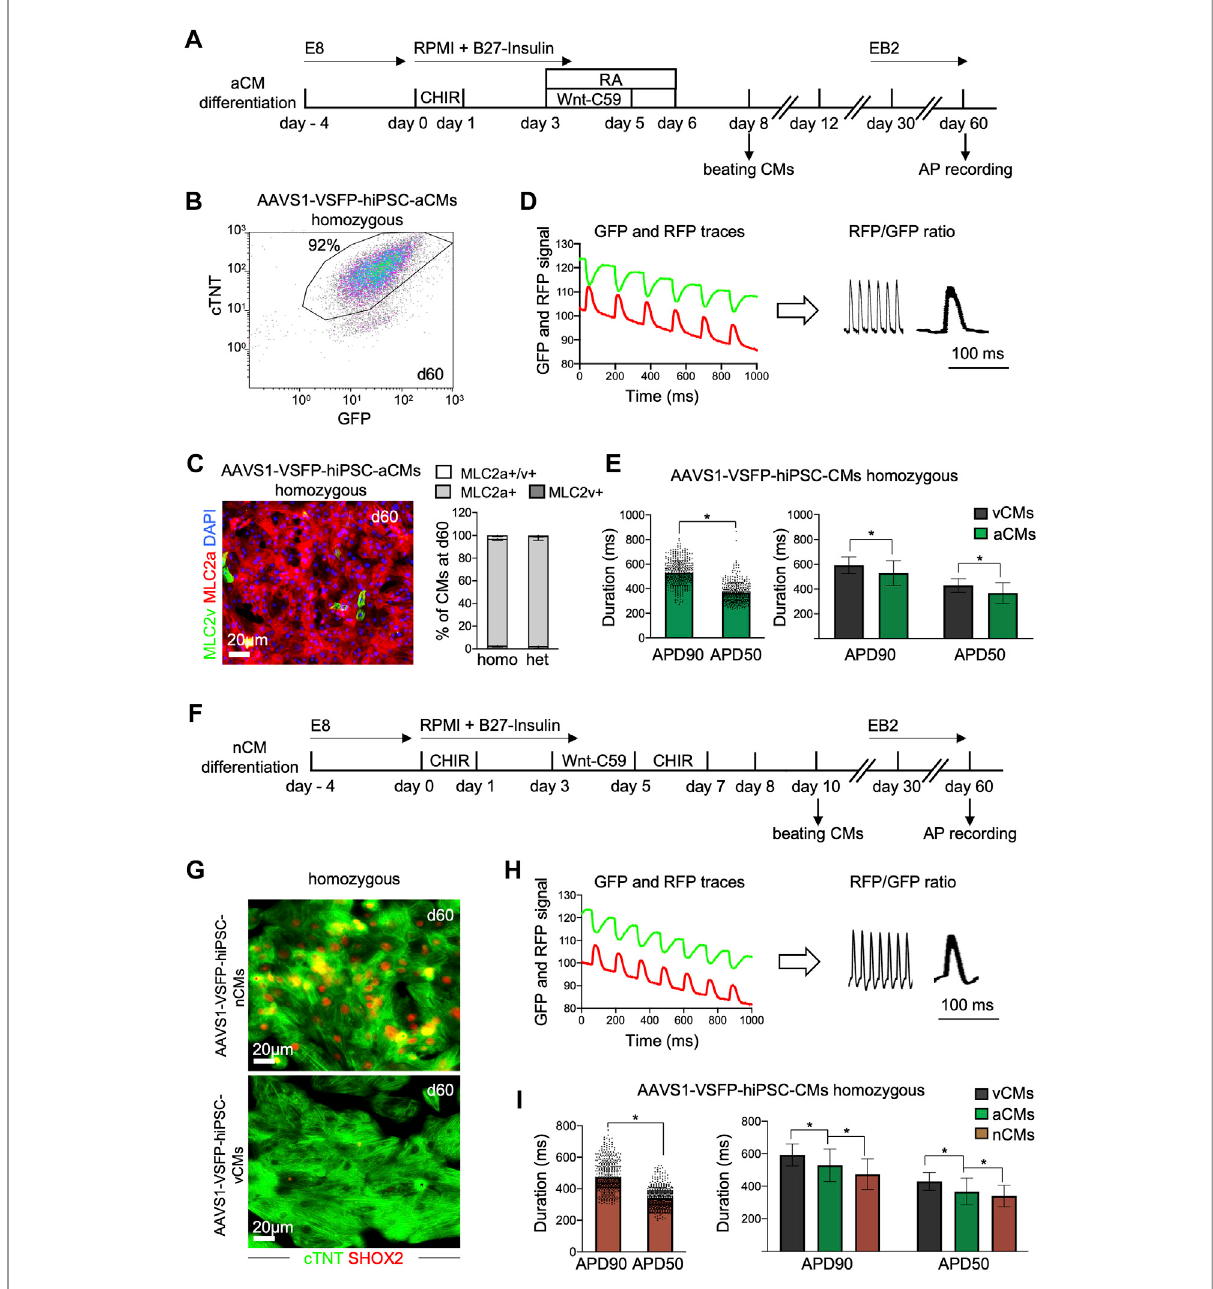
FIGURE 3 Differentiationand optical APrecordings ofAAVS1-VSFP-hiPSC-derived atrialand nodal CMs(AAVS1-VSFP-hiPSC-aCMs/nCMs). (A) Schematic representation of the protocol used for differentiation of hiPSCs into atrial CMs (aCMs). CHIR: CHIR-98014; RA: retinoic acid. (B) A representative fl ow cytometry plot showing d60 homozygous AAVS1-VSFP-hiPSC-aCMs immunostained with antibodies against cTNT and GFP. (C) Left panel, a representative image of d60 homozygous AAVS1-VSFP-hiPSC-aCMs immunostained with antibodies against MLC2v (green) and MLC2a (red). Nuclei werelabeledwith DAPI (blue). Right panel, quanti fi cation ofMLC2a+.MLC2a+/v+ and MLC2v+ AAVS1-VSFP-hiPSC-aCMs atday 60. Data are mean± SD; N = 507 homozygous and N =378heterozygous AAVS1-VSFP-hiPSC-aCMsfrom n =3 differentiations per line. (D) Spontaneousoptical AP measurement of atrialCMs. Background-corrected GFP and RFP fl uorescence traces of d60homozygous AAVS1-VSFP-hiPSC-aCMs (left panel). The APs are calculated as RFP/GFP ratio (right panel). (E) Quanti fi cation of APD90 and APD50 in d60 homozygous AAVS1-VSFP-hiPSC-aCMs at spontaneousbeating(leftpanel)andcomparisonofAPD90andAPD50betweenAAVS1-VSFP-hiPSC-vCMsand-aCMs(rightpanel).Dataaremean± SD; N = 61 vCMs from n = 3 differentiations and N = 434 aCMs from n = 5 differentiations; * p < 0.0001 (Mann-Whitney test). (F) Schematic representation of the protocol used for differentiation of hiPSCs into nodal CMs (nCMs). CHIR (d0-d1): CHIR-98014, CHIR (d5-d7): CHIR-99021. (G) Representative images of d60 homozygous AAVS1-VSFP-hiPSC-nCMs and -vCMs immunostained with antibodies against SHOX2 (red) and cTNT (green). (H) Spontaneous optical AP measurement of nodal CMs. Background-corrected GFP and RFP fl uorescence traces of d60